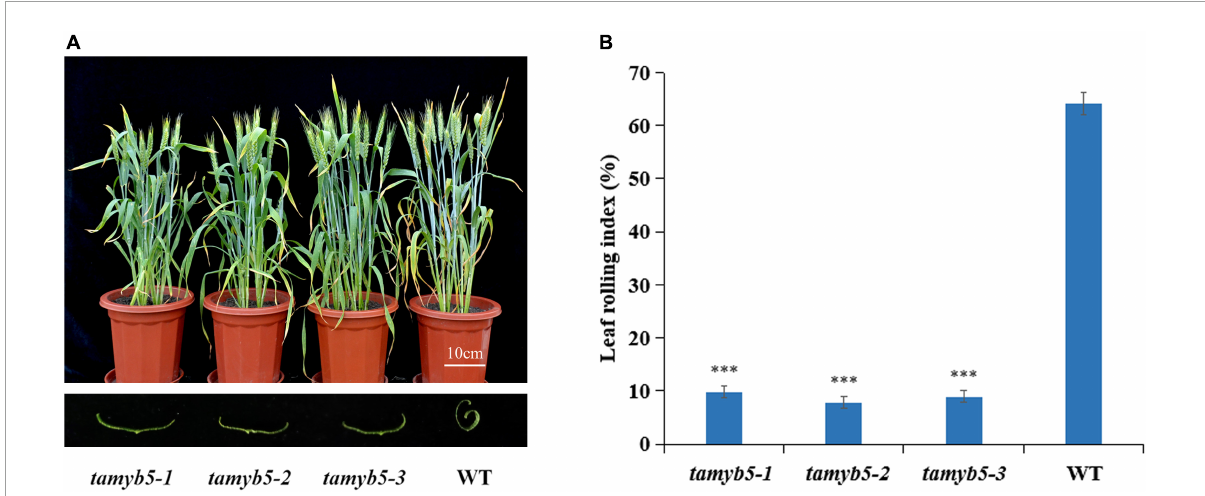
FIGURE2 The phenotypes of tamyb5 mutants and WT (wild-type AK58). (A) Phenotypes were observed under 18 days of drought treatment at the post-anthesis stage. The leaves of tamyb5 mutants were flatter than that of the WT. There is no significant phenotypic difference in leaf rolling between tamyb5 mutants and WT before drought stress. (B) Leaf rolling index (LRI) of WT and tamyb5 . Data are presented as mean ± SE ( n = 9). ∗∗∗ P < 0.001.